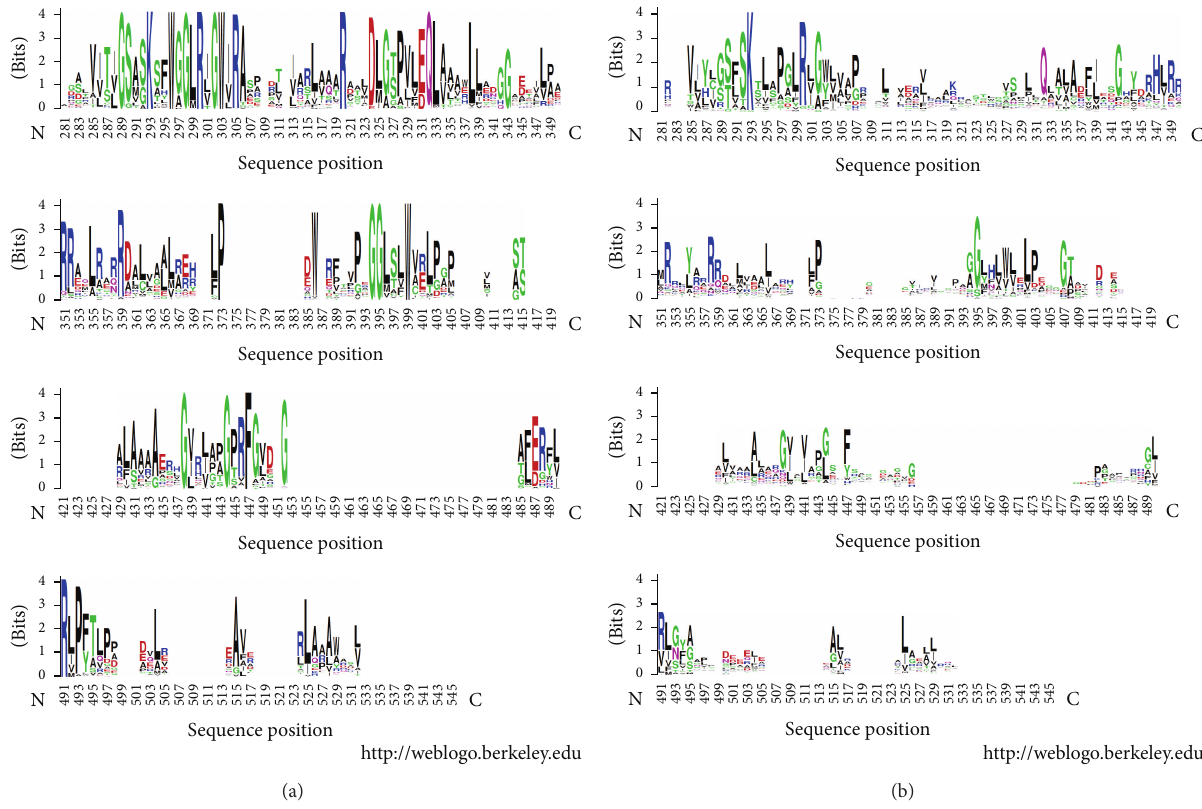
Figure 5: Logos of the alignments of the AAT domain sequences. Logos of the alignments of the AAT domain sequences from (a) YczR and (b) MocR/other. Logos were calculated by the site WebLogo. Letters and colors have the meaning described in the caption of Figure